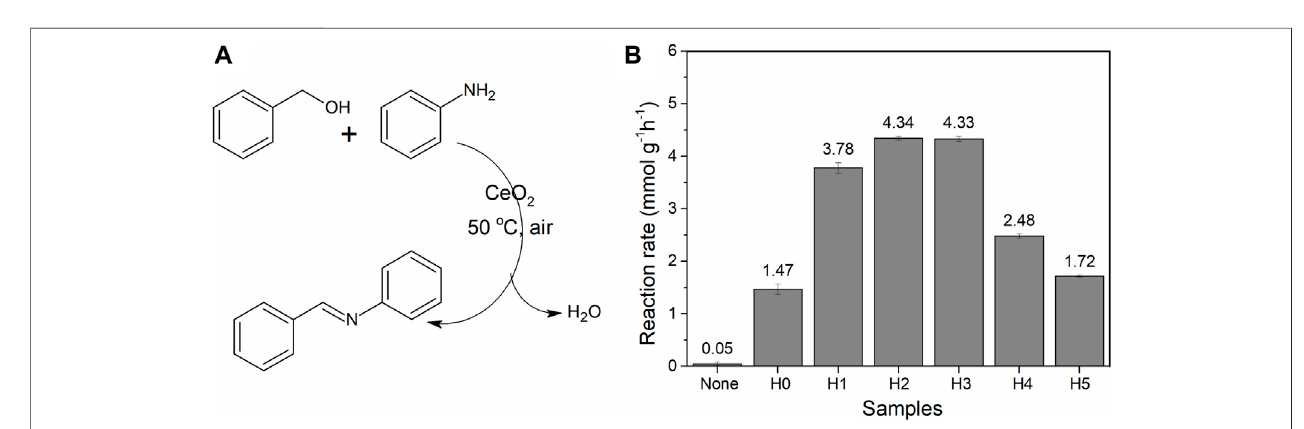
FIGURE7|(A) Reactionforiminesynthesis. (B) ImineconversionofCeO 2 (50 mg)synthesizedindifferentamountsofwater(amountofcatalystperhour;allvalues of conversion are calculated below 20%). The experiment was repeated three times, and the average conversion value was given with an error